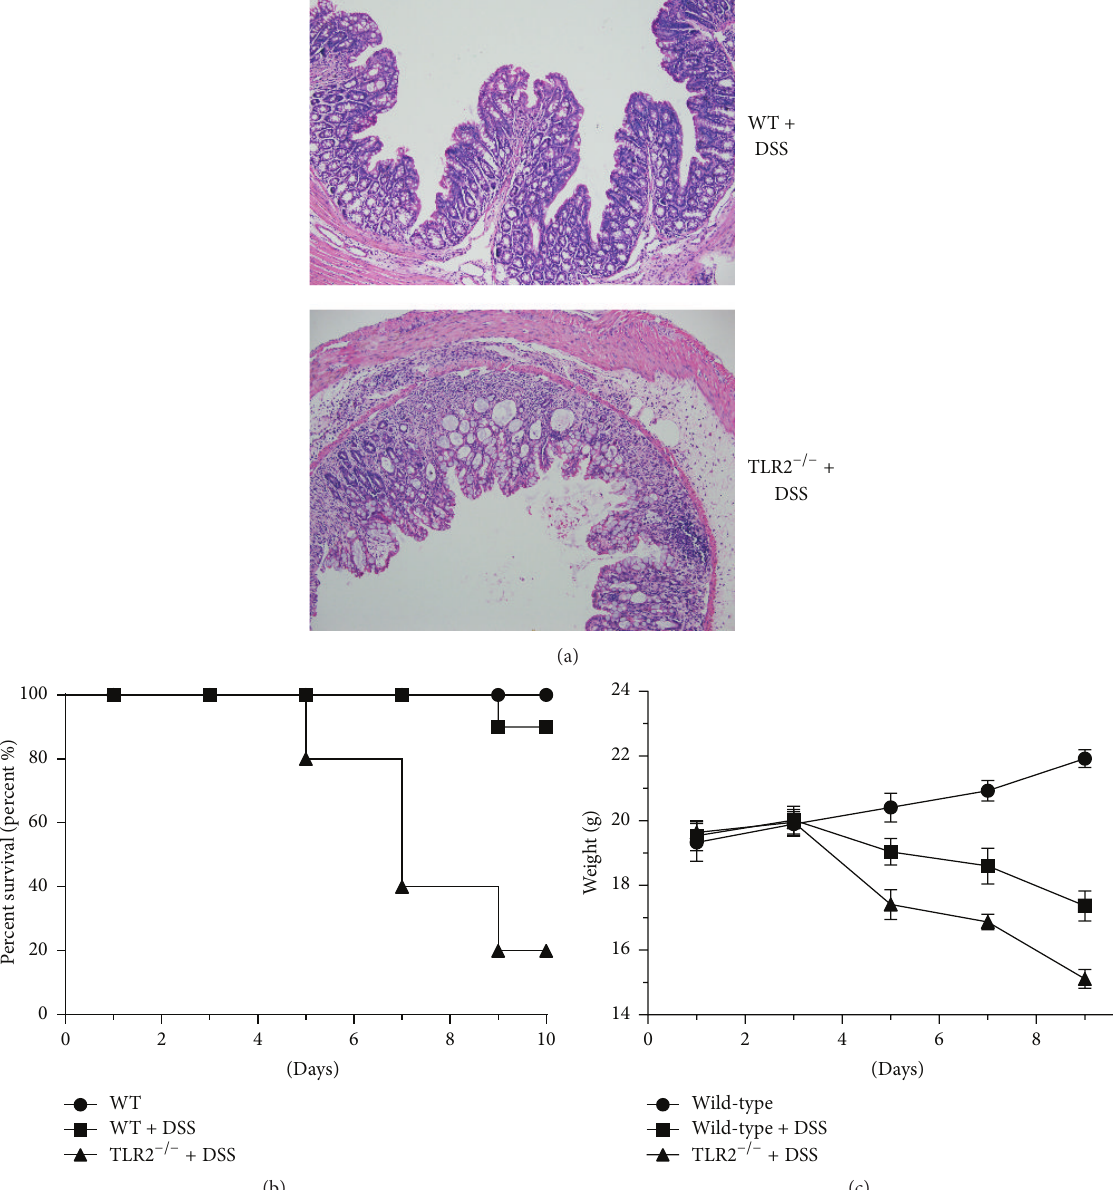
Figure 5: Histopathological characterization of DSS-induced colitis. (a) H&E staining of colons of 3% DSS-treated controls or TLR2-deficient mice. Images are 200x. (b) Survival rates were recorded. (c) Body weight was determined once every other day between day 1 and day 9. Ten mice per group from three independent